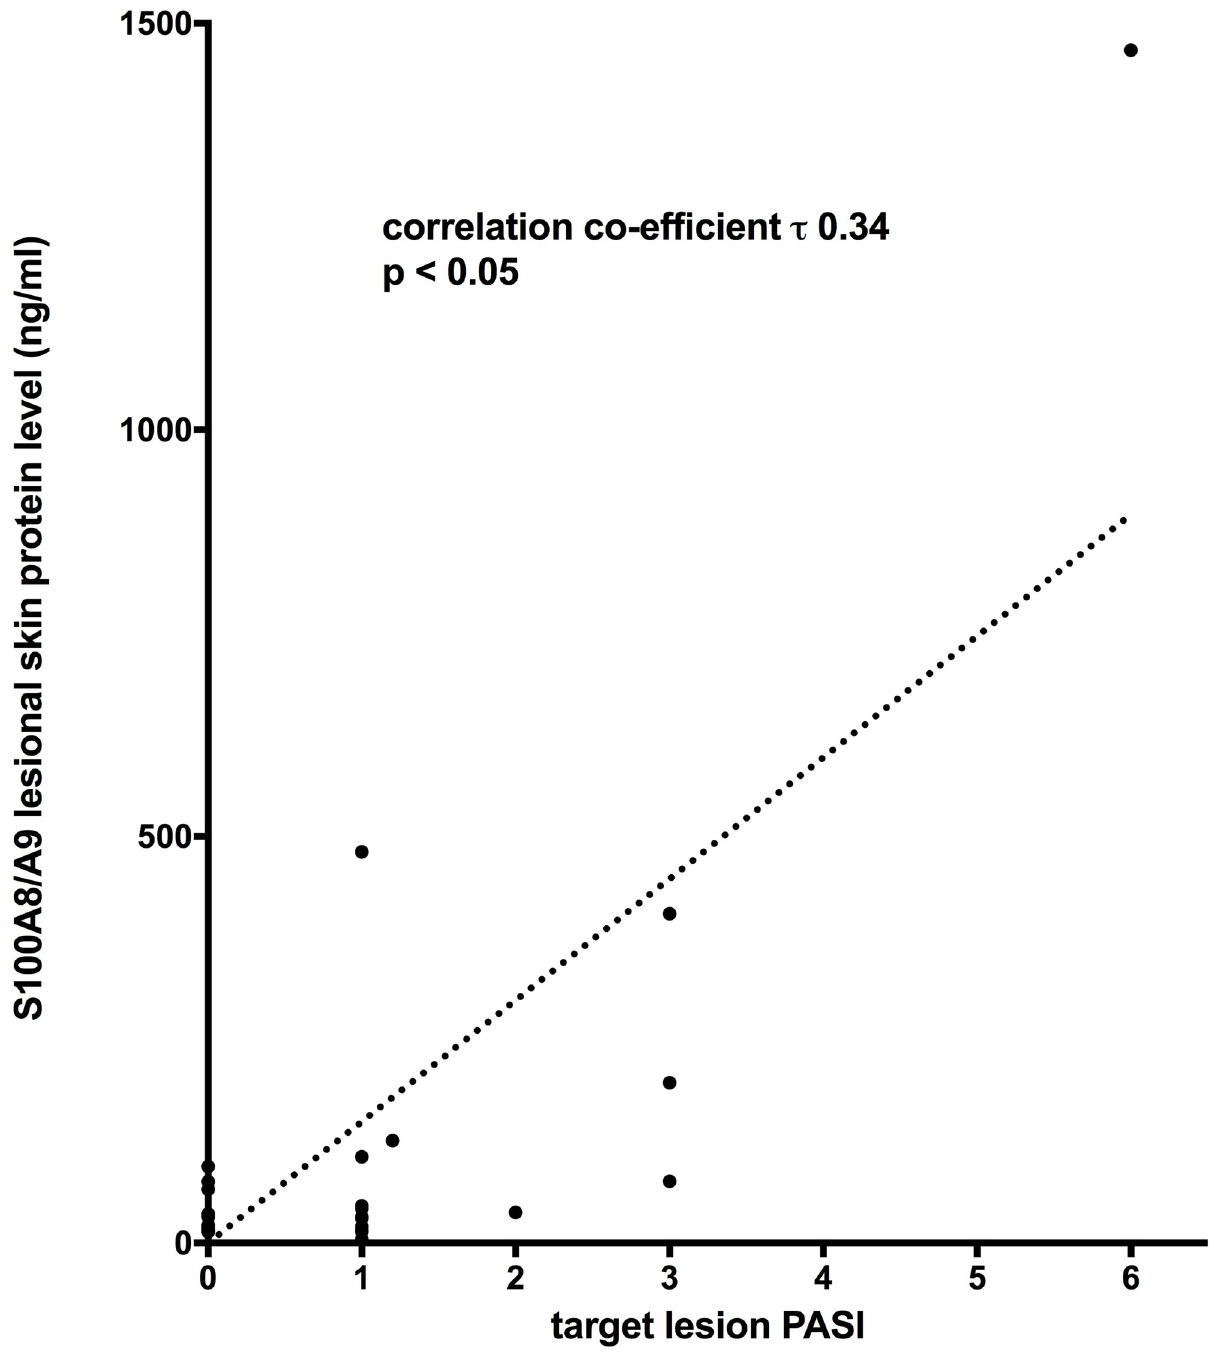
Fig 7. S100A8/A9 protein in lesional skin after NB-UVB and target lesion PASI. A moderate correlation was found. https://doi.org/10.1371/journal.pone.0213344.g007 expression of S100A15 (Koebnerisin) and S100A7 (Psoriasin) are increased in circulating peripheral blood mononuclear cells (PBMCs) in patients with psoriasis [28]. If S100A8 and S100A9 share similar expression patterns then it is possible that PBMCs could be a source of elevated S100A8/A9 in serum.